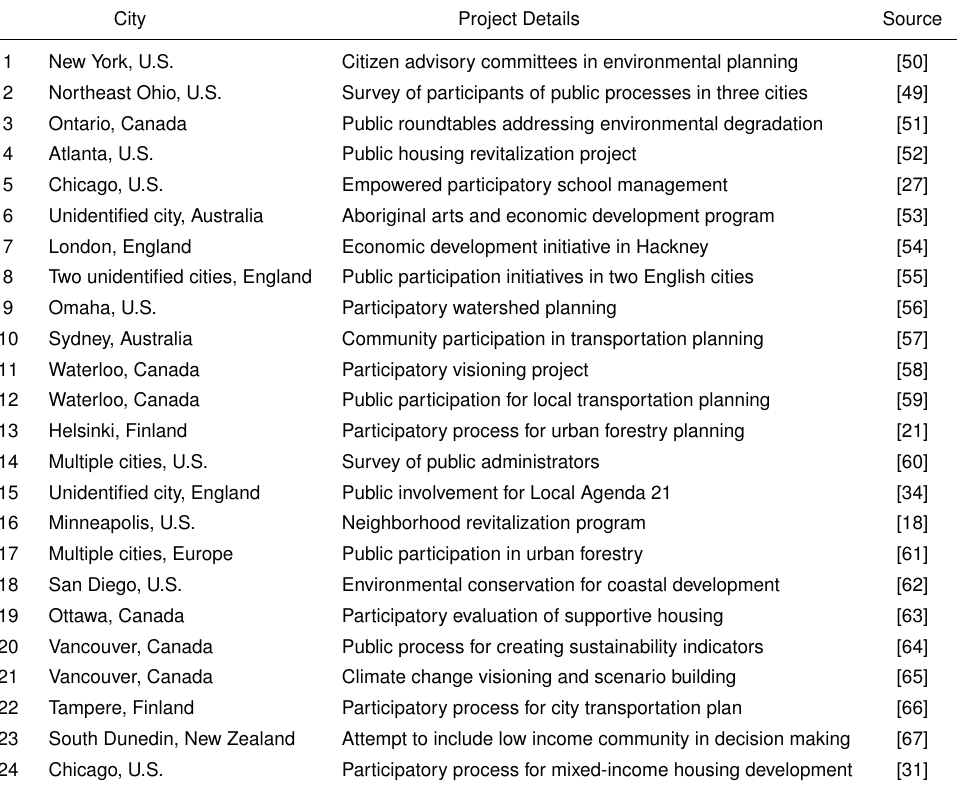
Table 1. Case studies from the literature for misalignment